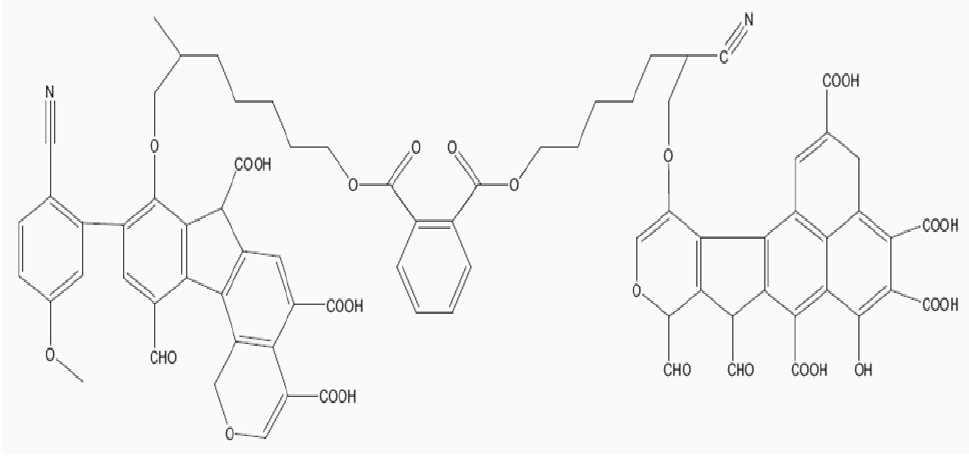
Figure 1. A conceptual structure of biochar [5].